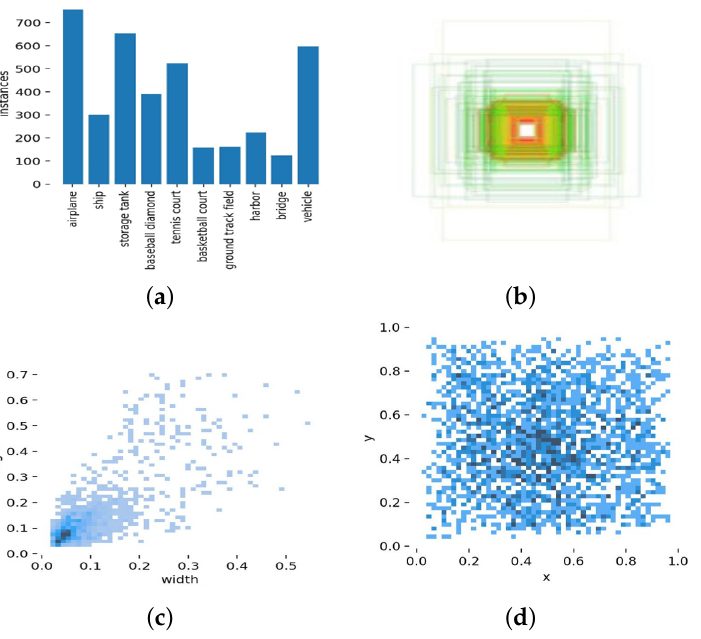
Figure 7. Details of the NWPU VHR-10 dataset: ( a ) number of labels in various categories; ( b ) visualization plot of all labeled boxes aggregated at the center; ( c ) statistical plot of the width and height of all labels; ( d ) heat map of all labels occurring at the image